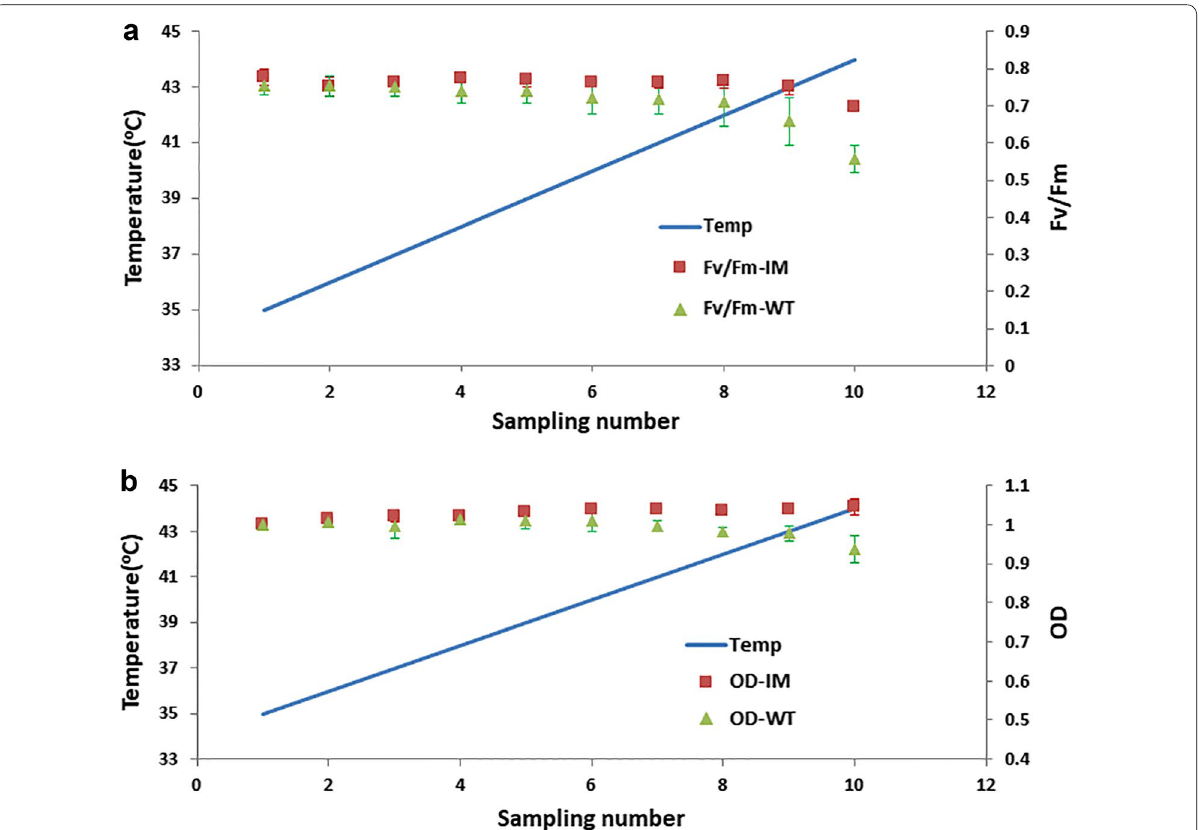
Fig. 3 Growth and chlorophyll fluorescence curve of WT and mutant IM at different temperatures. a F v /F m and b OD curve. All points represent the mean SD of three individual ±